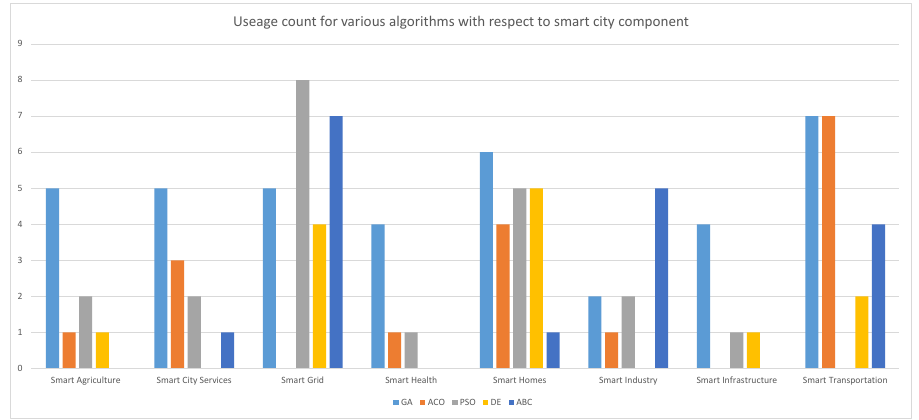
Figure 10. Count of different algorithms used with respect to Smart City Component.